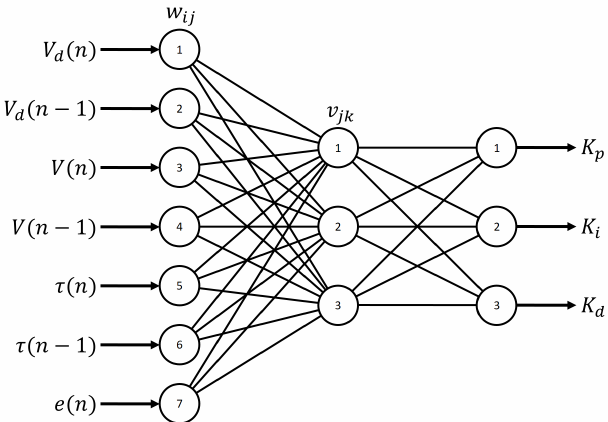
Figure 9. Three-layer artificial neural network topology for tuning the PID control